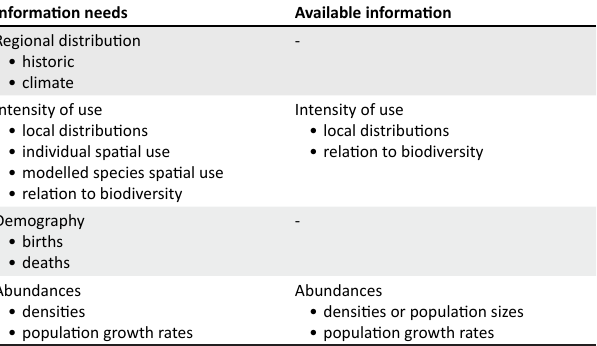
TABLE 5 : Example of information needs of SANParks based on the requirements of monitoring to support and evaluate management actions and their effects on objectives and summary of current data sets available for the specific